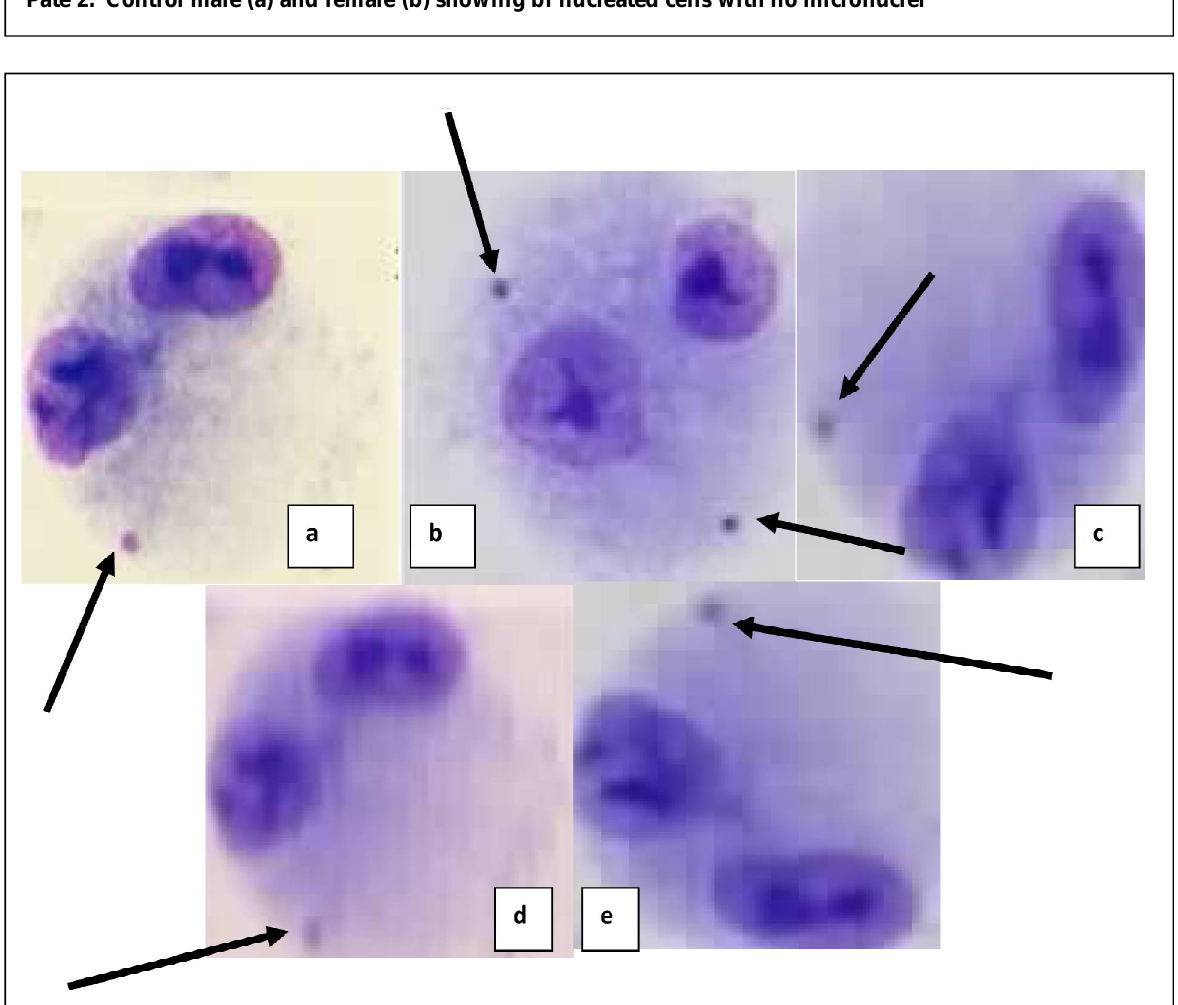
Plate 3: Group B Males and Females- a – binucleated cell with one MN; b – binucleated cells with two MN; c- bnucleated cell with one MN; d - binucleated cell with one MN and e - binucleated cell with one